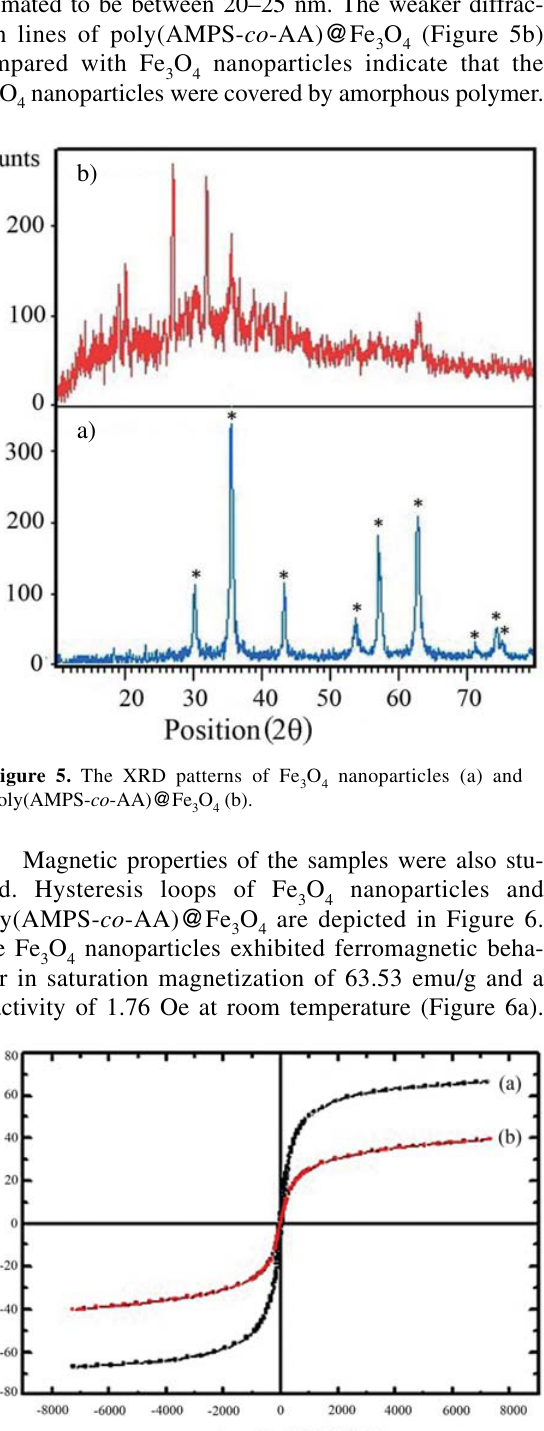
Figure 7. 1 H NMR spectrum of the 3,3’-(4-nitrobenzylidene)-bis-